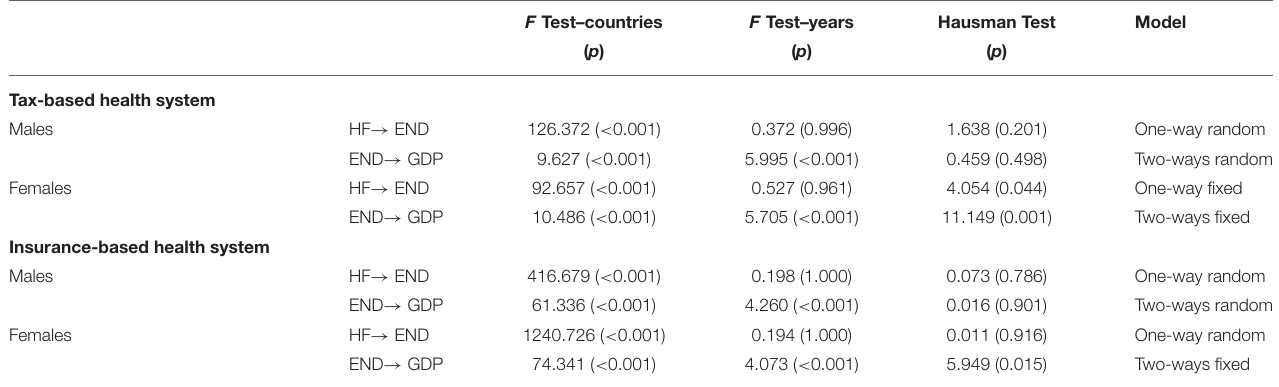
TABLE 4 | Testing of assumptions for the selection of regression models in the diagnosis group of endocrine, nutritional and metabolic diseases.